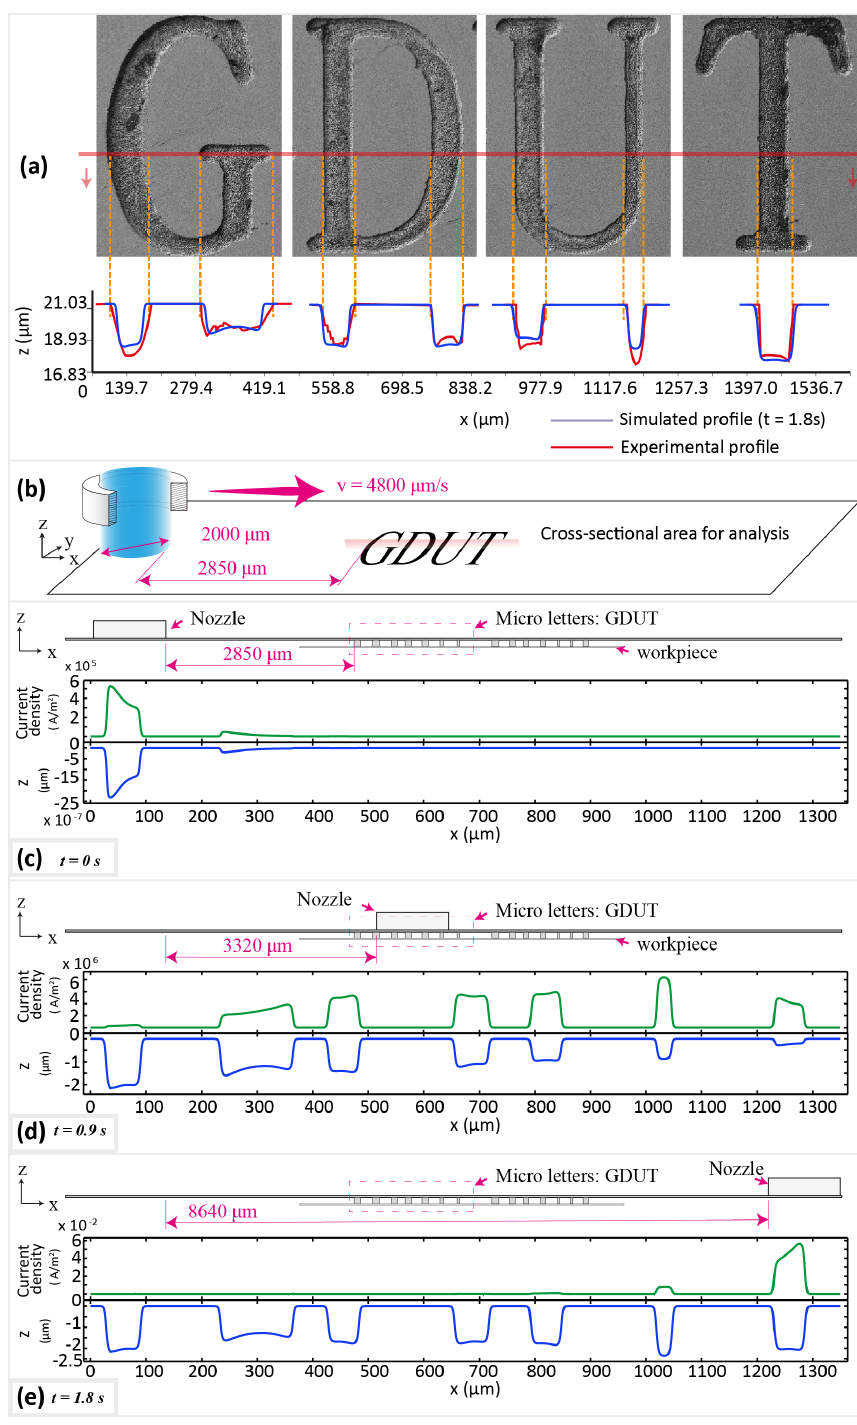
Figure 5. The effect of the topography of microstructures on the distribution of current density. ( a ) Simulated and experimental cross-sectional profile; ( b ) Schematic view of the cross-sectional research area; ( c – e ) Cross-sectional current density distribution and profile at t = 0 s, 0.9 s, 1.8